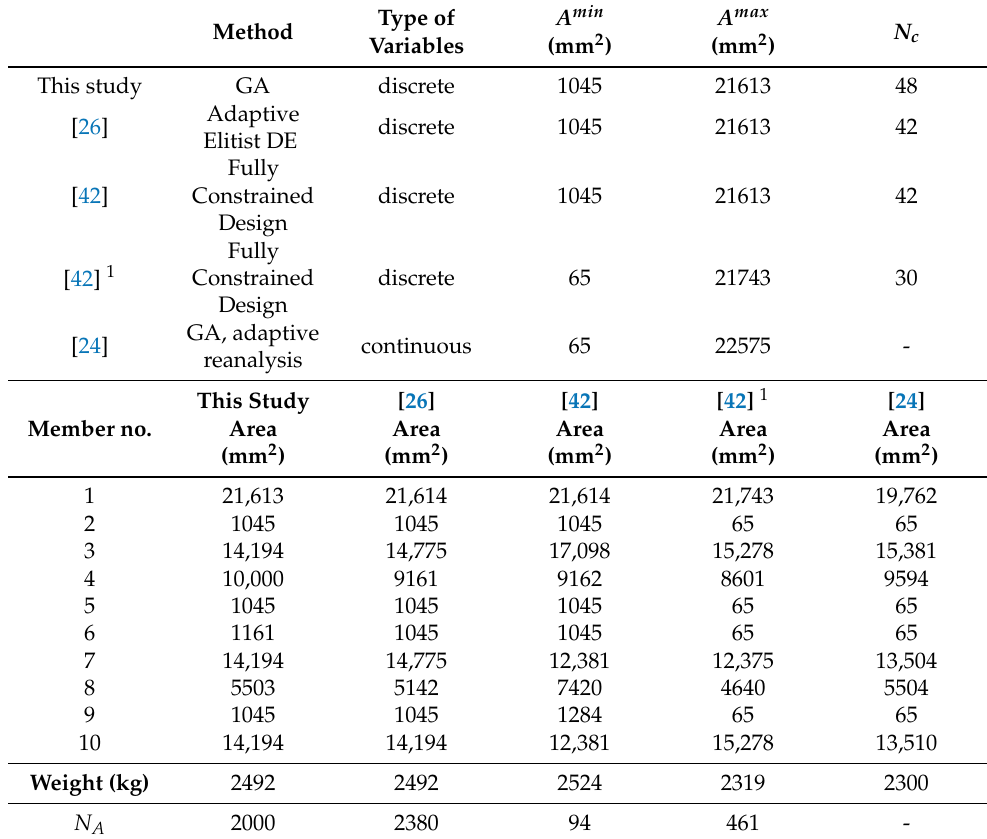
Table 2. Basic information about the compared solutions and comparison of GA optimization results with the literature for the 10-bar truss